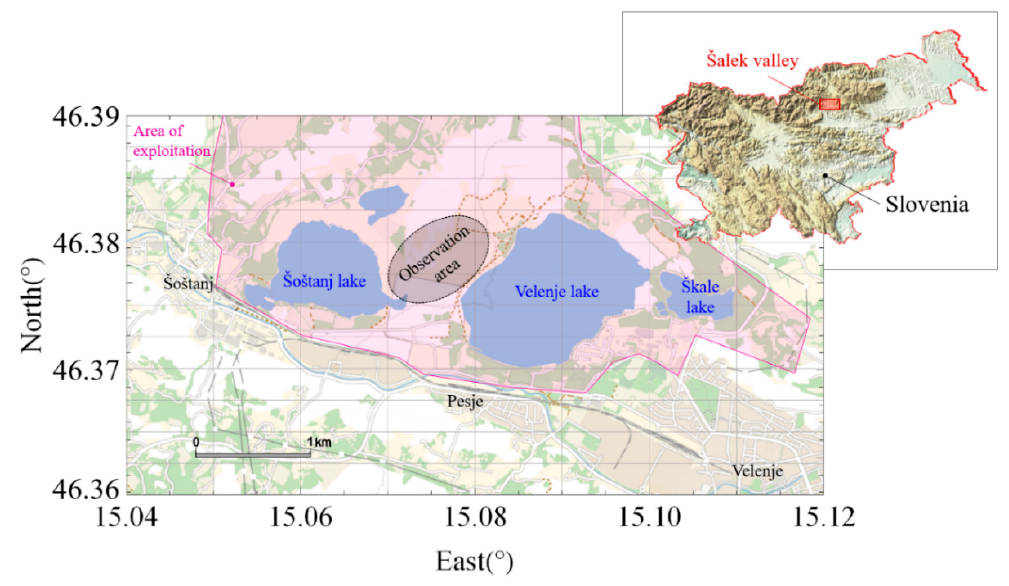
Figure 2. The observation area is located in the Šalek valley in N-E Slovenia, on the surface of Velenje coal mine (VCM) exploitation area between Lake Šoštanj and Lake Velenje.